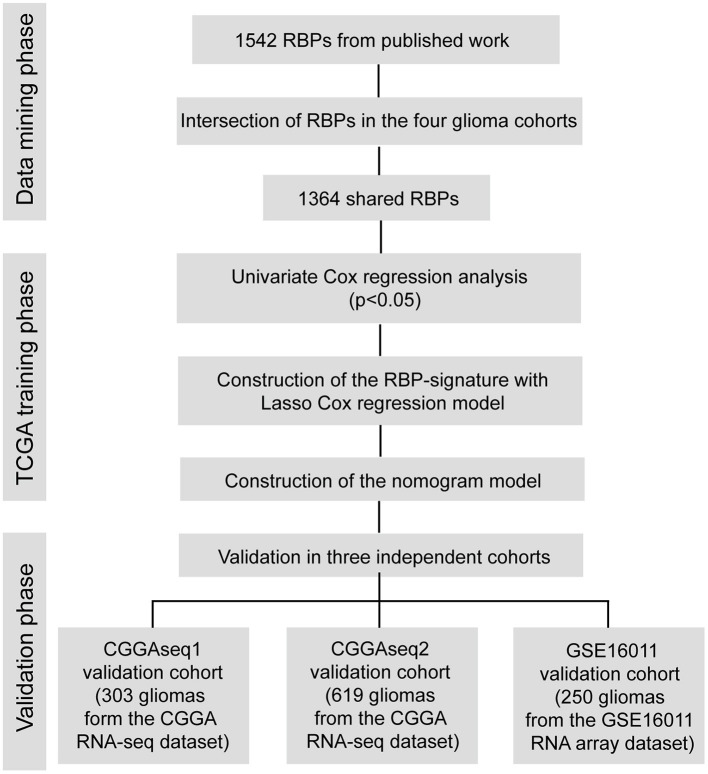
Flow chart of this study.